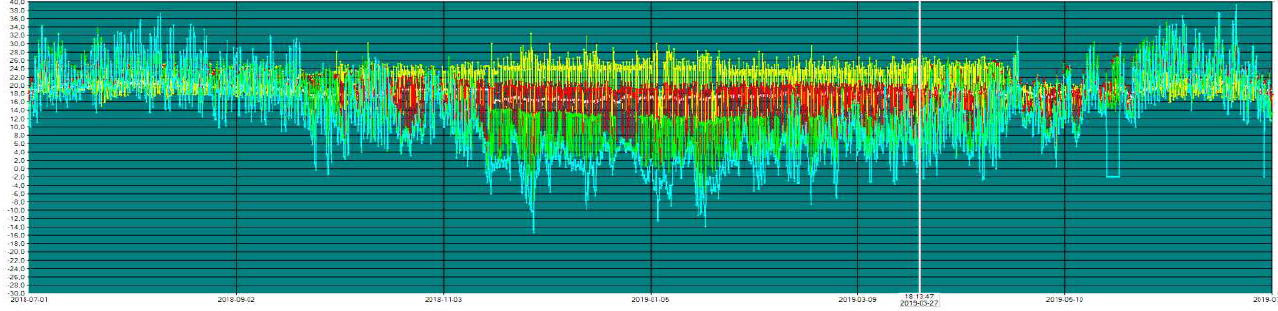
Figure 6. Example of indoor parameters: winter–summer, 1 July 2018 to 1 July 2019; indoor temperature, +18.5 °C; outdoor temperature, −16.0 °C. Line blue—outdoore temperature, green—supply temperature on the heaters, red—supply temperature after the heat exchangers, yellow—supply air temperature, white—indoore temperature.